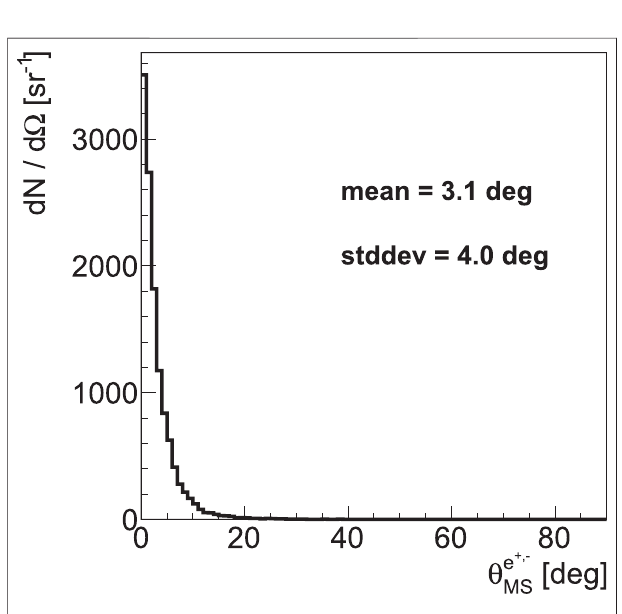
FIGURE 5 | Distribution of the angle θ e + , − MS between the leptons ’ momentum directions at the entrance and at the exit of the fi rst tracker plane, due to the multiple scattering within the fi rst tracker plane, for the lepton pairs reaching the calorimeter. The distribution has been weighted with the solid angle 2 π sin ( θ ) d θ , with d θ (cid:3) 1 + · π / 180 +